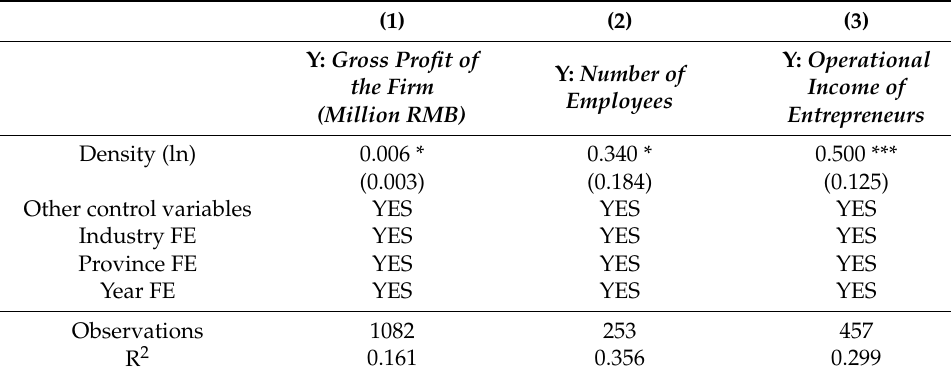
Table 8. Rewards for entrepreneurs in large